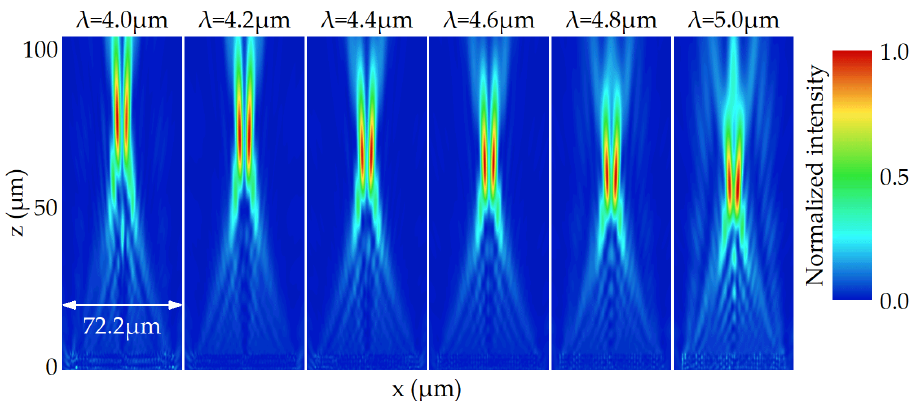
Figure 2. The simulated electric field intensity on the x-z plane for the FVBG with regular negative dispersion between 4.0 and 5.0 μ m.